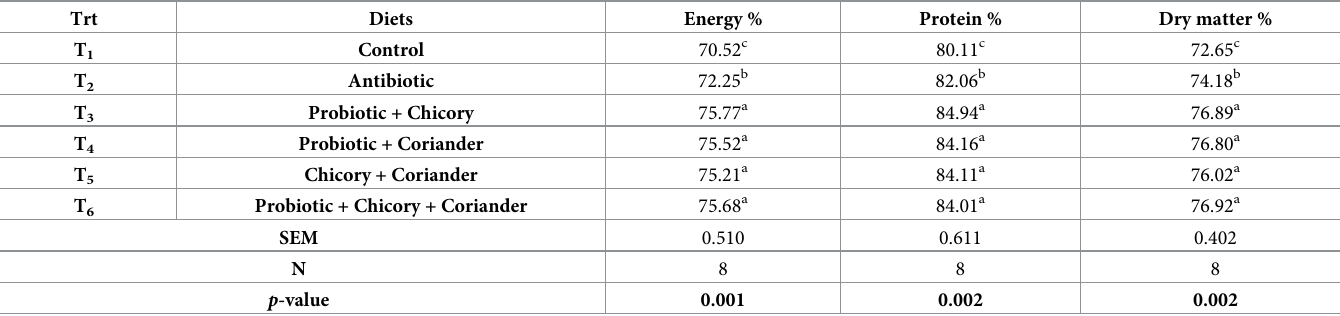
Value bearing different superscripts within a column are significantly (P < 0.05)